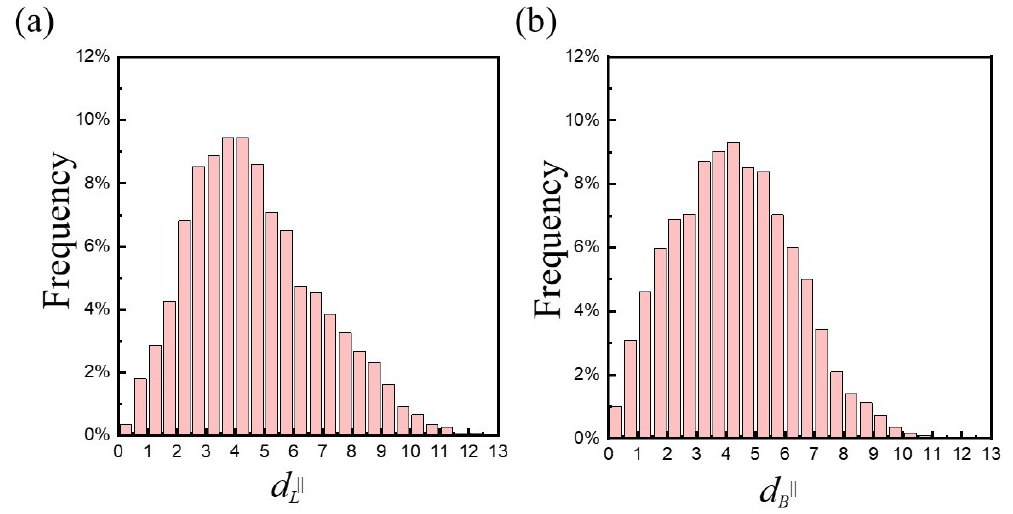
Figure 5. The distribution of the end-to-end distance parallel to the membrane surface for the ( a ) loop (cid:107) (cid:105) ) and ( b ) bridge ( (cid:104) d (cid:107) ( (cid:104) d L